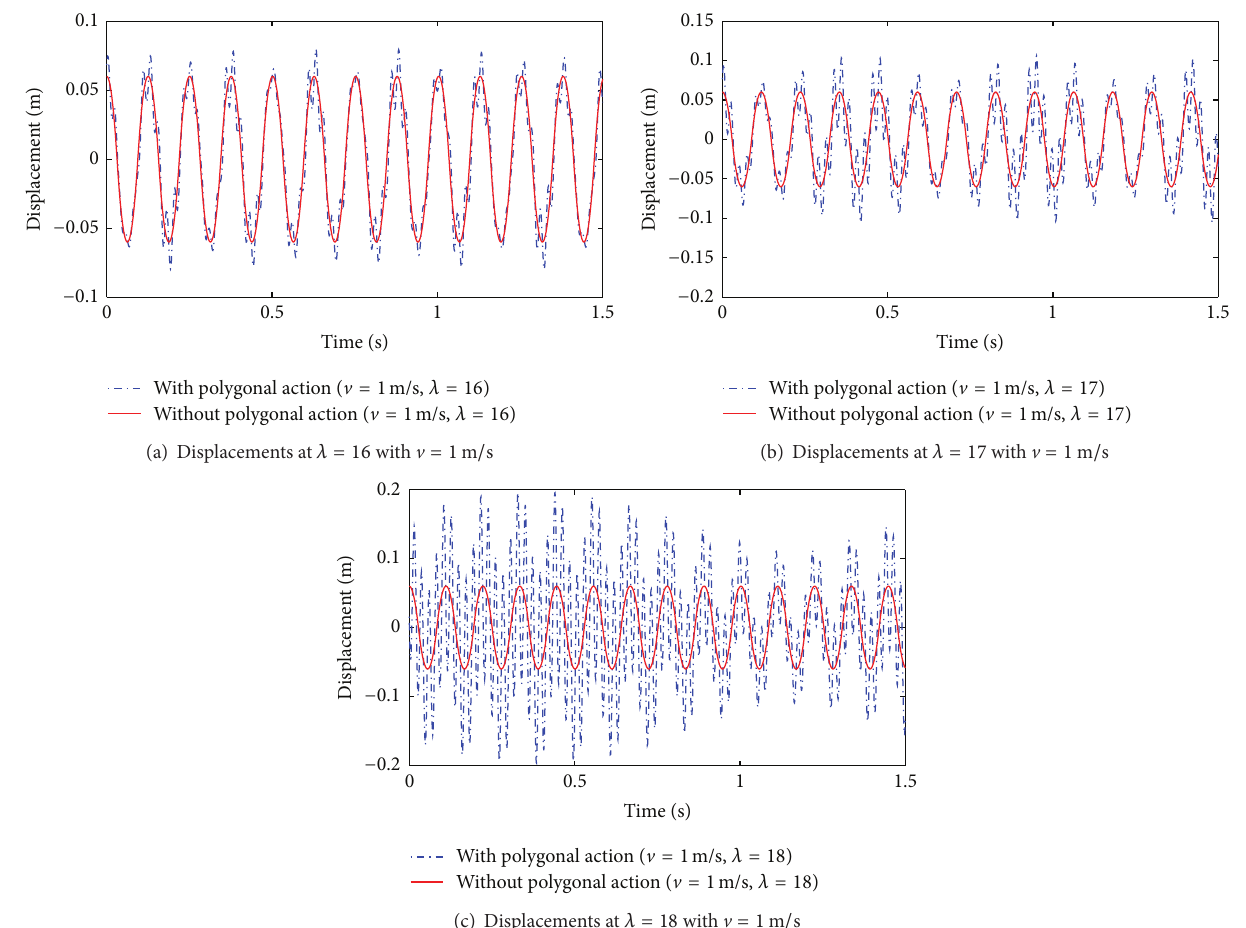
Figure 8: Comparison of vibration displacements with or without polygonal action.